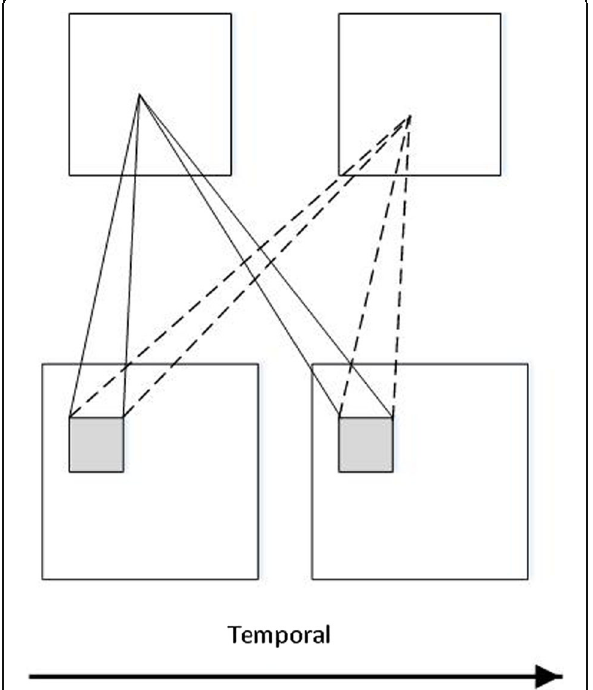
Fig. 4 Multiple convolutional